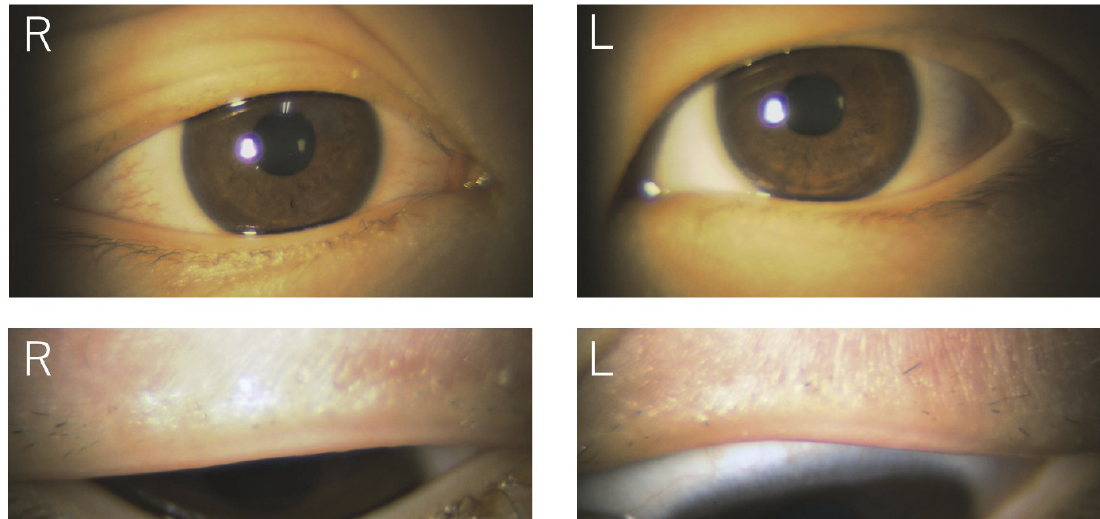
Figure 1: Slit-lamp photographs of an 8-year-old boy with trichotillomania of the eyelashes of both eyes. Photograph taken at initial visit.